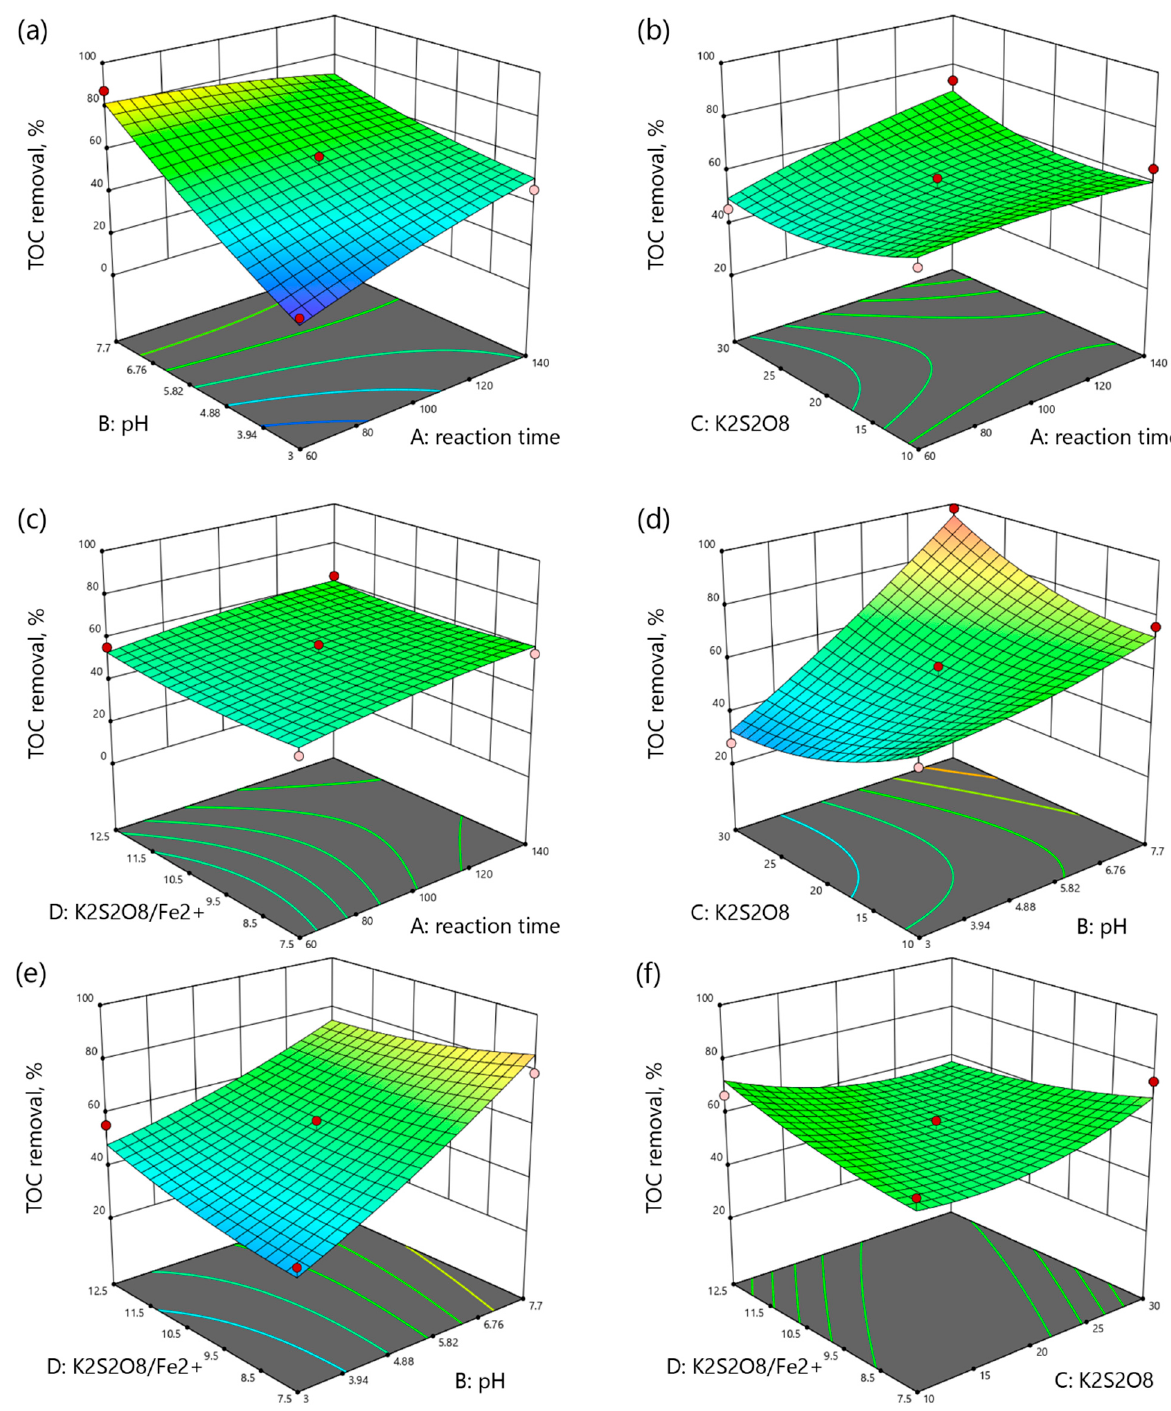
Figure 4. 3D plots of TOC removal as a function: ( a ) reaction time (min) and pH, ( b ) reaction time (min) and K 2 S 2 O 8 concentration (mM), ( c ) reaction time and K 2 S 2 O 8 /Fe 2+ molar ratio, ( d ) pH and K 2 S 2 O 8 concentration (mM), ( e ) pH and